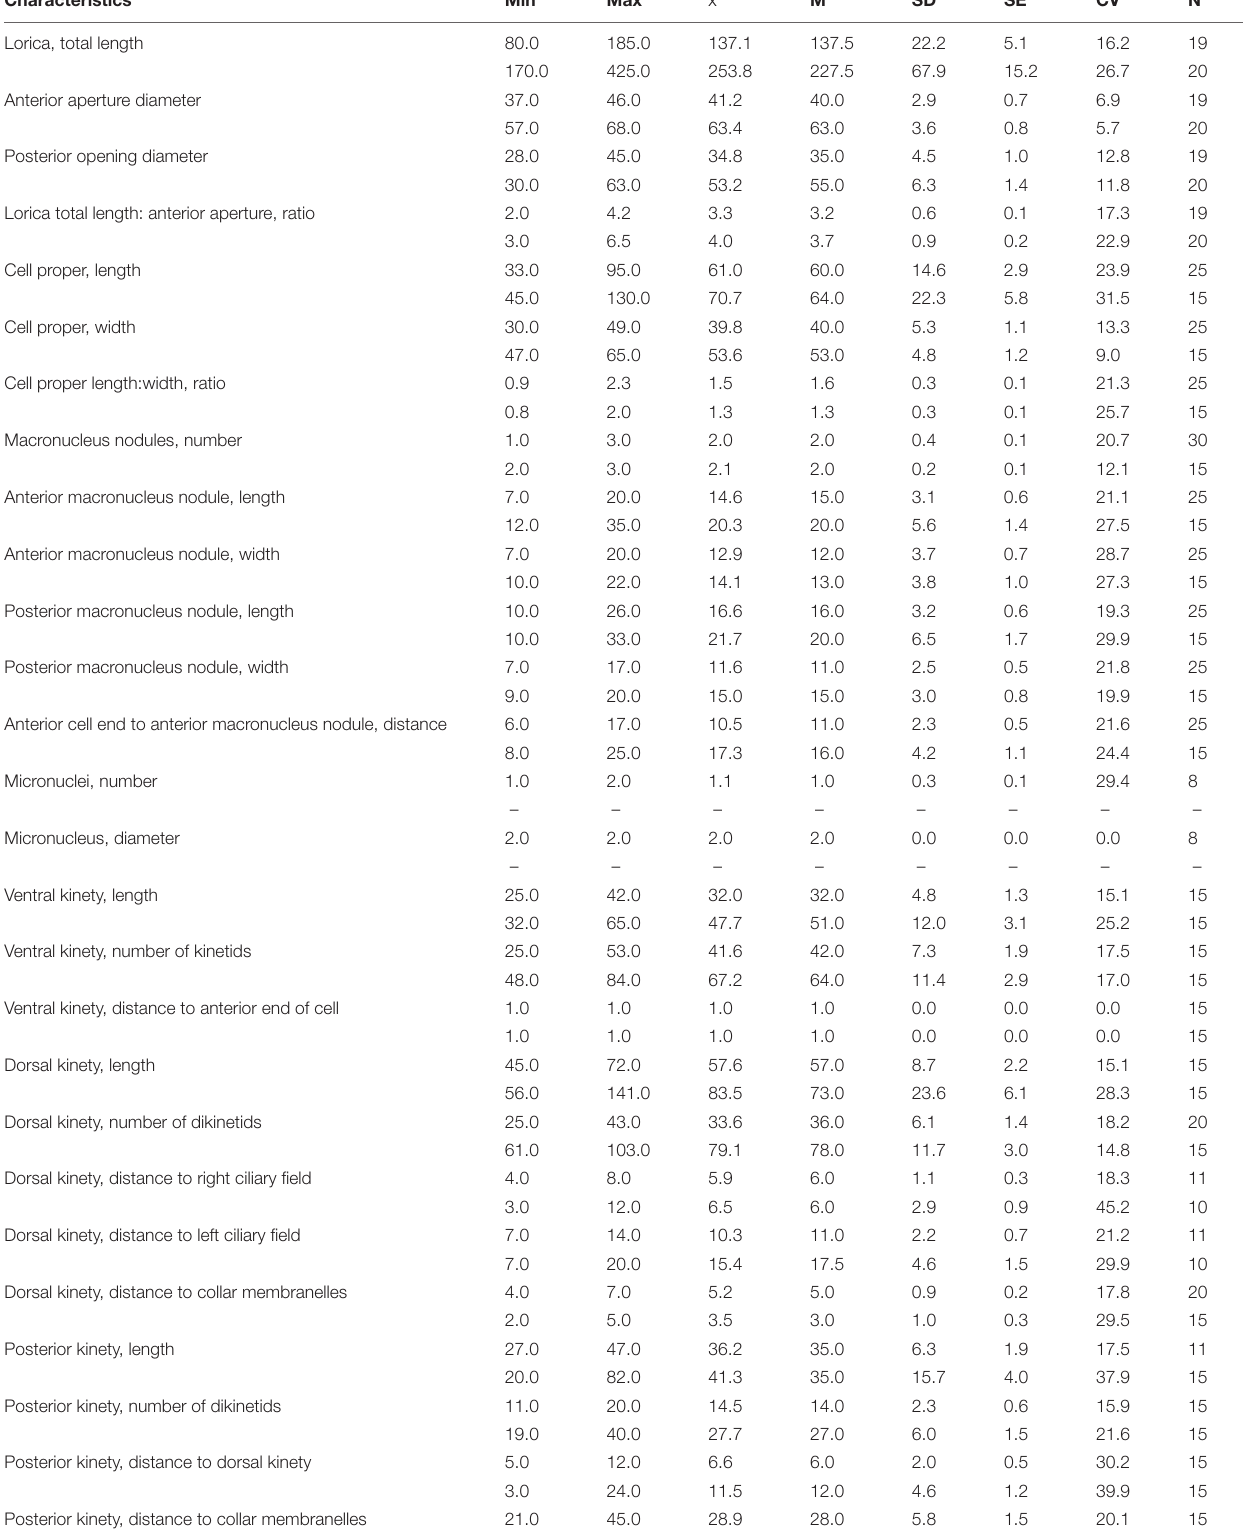
TABLE 1 | Morphometric data of Leprotintinnus nordqvisti (upper line) and L. simplex (lower line).